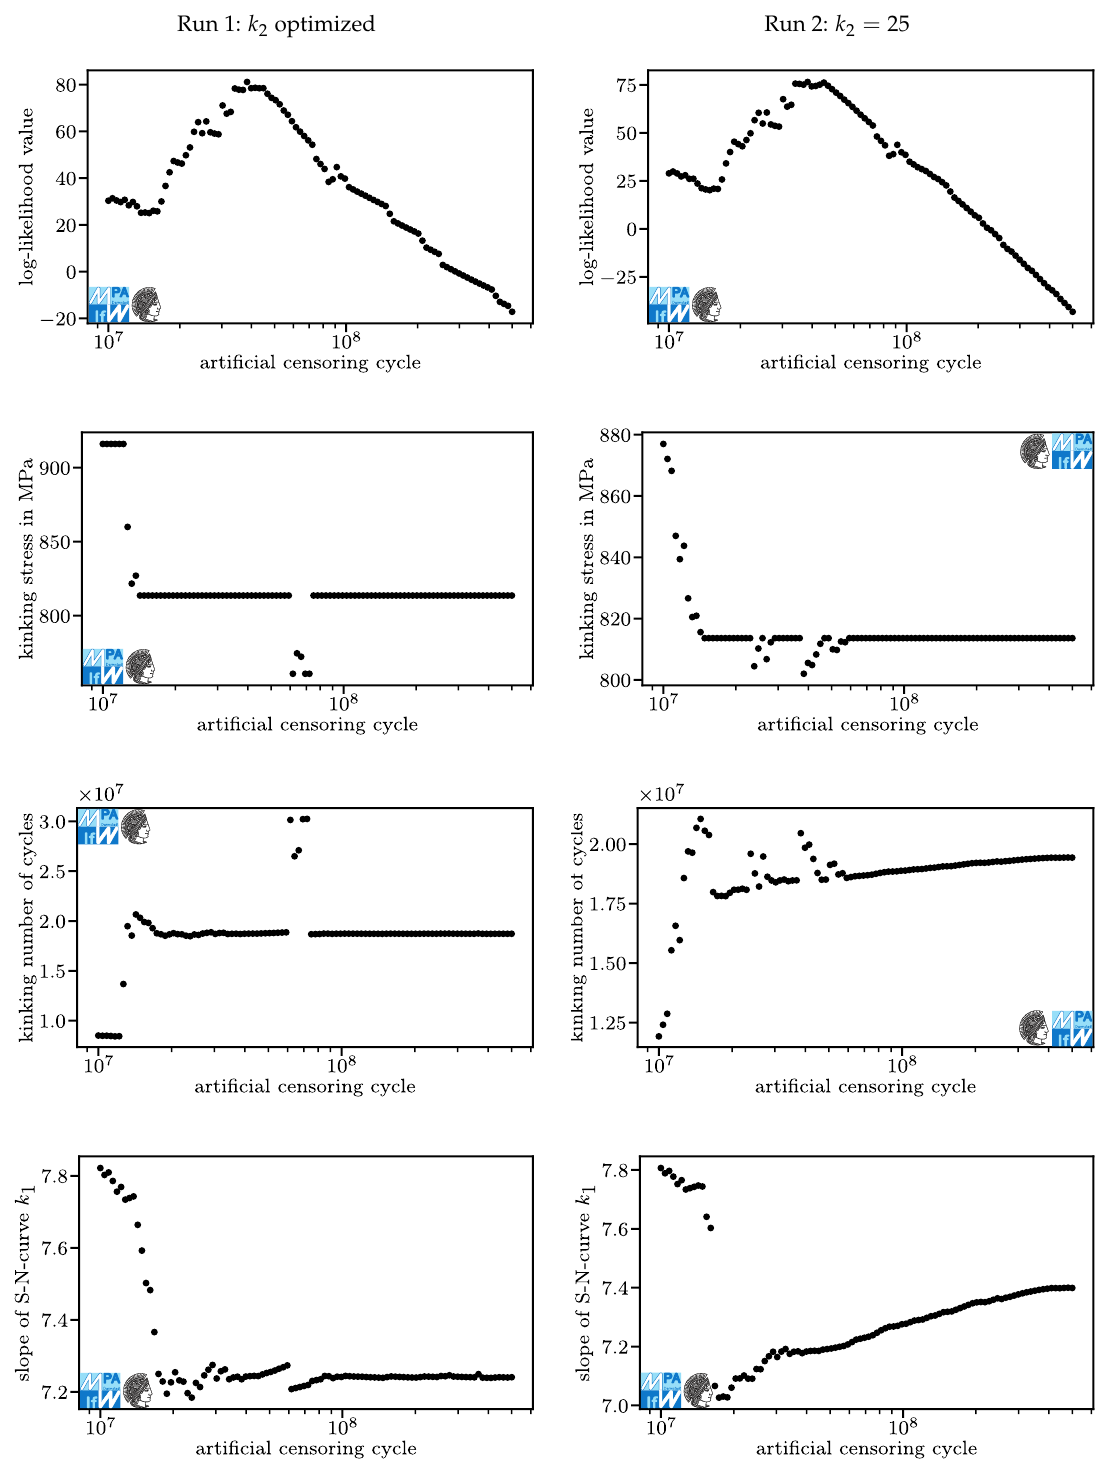
Figure 6. Results of optimization processes for Run 1 ( left ) and Run 2 ( right )